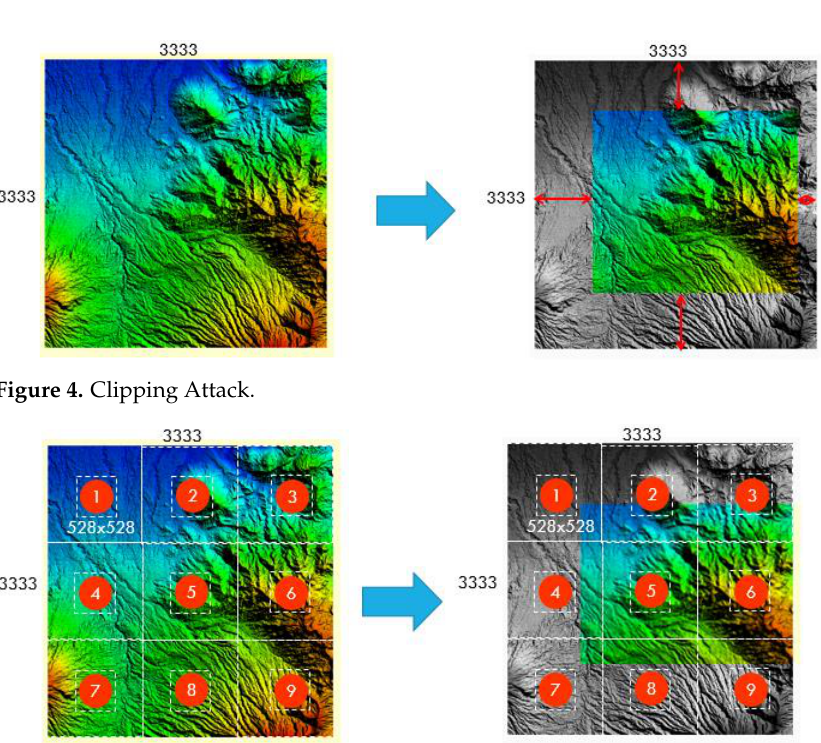
Figure 5. Clear Illustration of Clipping Attack.